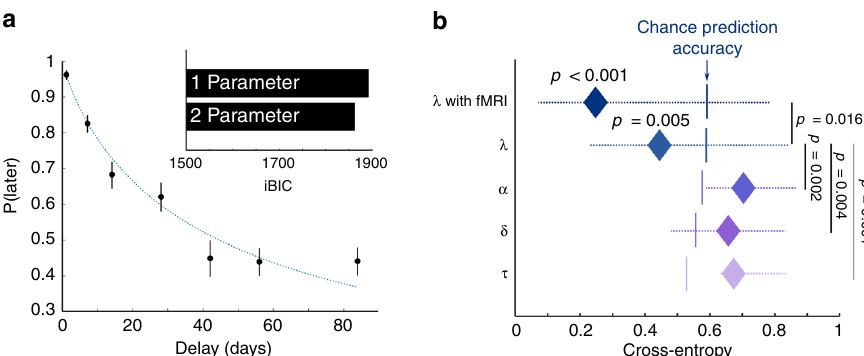
Fig. 6 Temporal discounting propensity can be predicted by Self-Other distinction. a Choice behaviour in the intertemporal choice task. Each scatter point shows the proportion of trials, averaged over n = 40 independent subjects, where the larger later option was chosen. The inset bar plot shows the relative fi ts of one- and two-parameter hyperbolic discounting models in terms of integrated Bayesian information criterion (iBIC). The two-parameter hyperbolic discounting curve, using the mean parameters across subjects, is shown as a blue dashed line. Error bars denote s.e.m. b Performance of fi ve logistic regression models predicting subjects ’ temporal discounting propensities, using various predictors, with leave-one-subject-out cross-validation. Data is presented as median cross-entropy ± interquartile range, across n = 40 independent subjects. Lower cross-entropy denotes more accurate prediction. Discounting propensity could be predicted, above chance, using the leak parameter ( λ ): p = 0.005. Prediction accuracy was signi fi cantly better with λ than with any other behavioural parameter from the false belief task (learning rate p = 0.002, memory decay p = 0.004, temperature p = 0.001). Prediction accuracy ( p < 0.001) was signi fi cantly improved ( p = 0.016) when Self-Other cross-decoding accuracies from the fMRI analysis were included as additional predictors in a new logistic regression model. All p values were derived from two-sided permutation tests (see Methods). Vertical bars show chance level prediction accuracy for each logistic regression model. Source data are provided as a Source Data fi correlation: ρ = − 0.32, p = 0.043]. In effect, subjects who showed